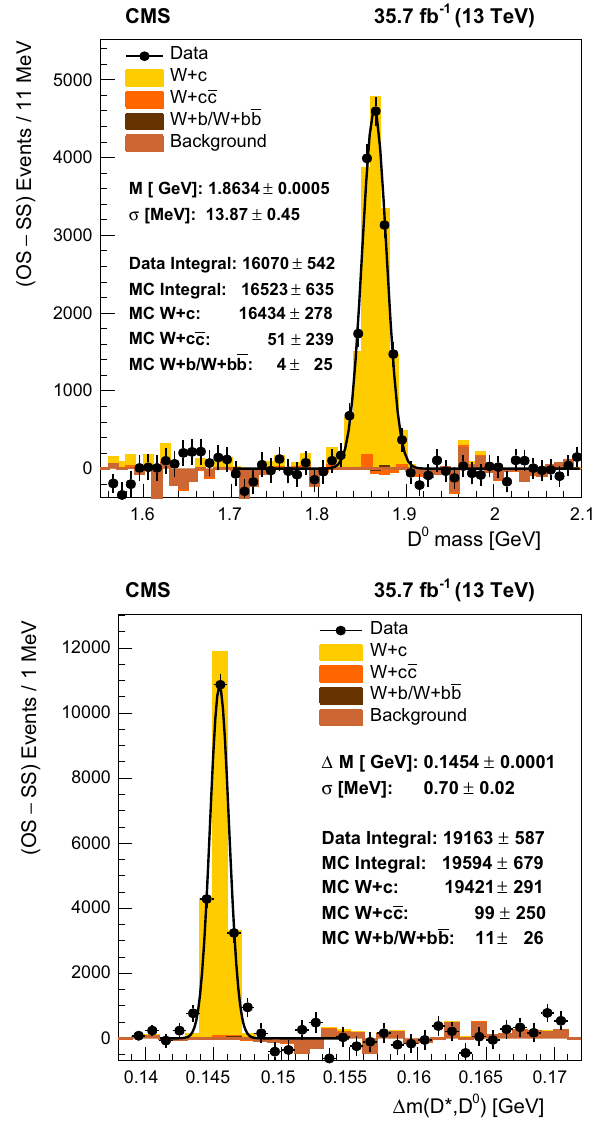
Fig. 2 Distributions of the reconstructed invariant mass of K ∓ π ± can- didates (upper) in the range | Δ m ( D ∗ , D 0 ) − 0 . 1454 | < 0 . 001GeV, and the reconstructed mass difference Δ m ( D ∗ , D 0 ) (lower). The SS com- binations are subtracted. The data (filled circles) are compared to MC simulation with contributions from different processes shown as his- tograms of different shades